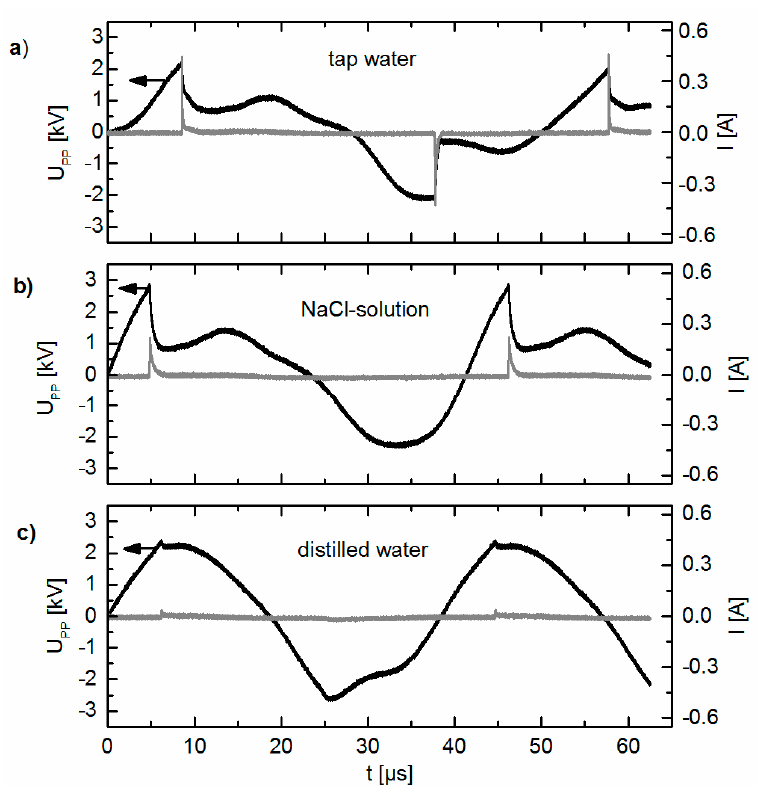
Figure 4. Electrical characterization for different treated liquids measured on one electrode: ( a ) tap water σ = 0.648 mS / cm, ( b ) saline solution σ = 16.23 mS / cm, ( c ) distilled water σ = 0.013 mS / cm.